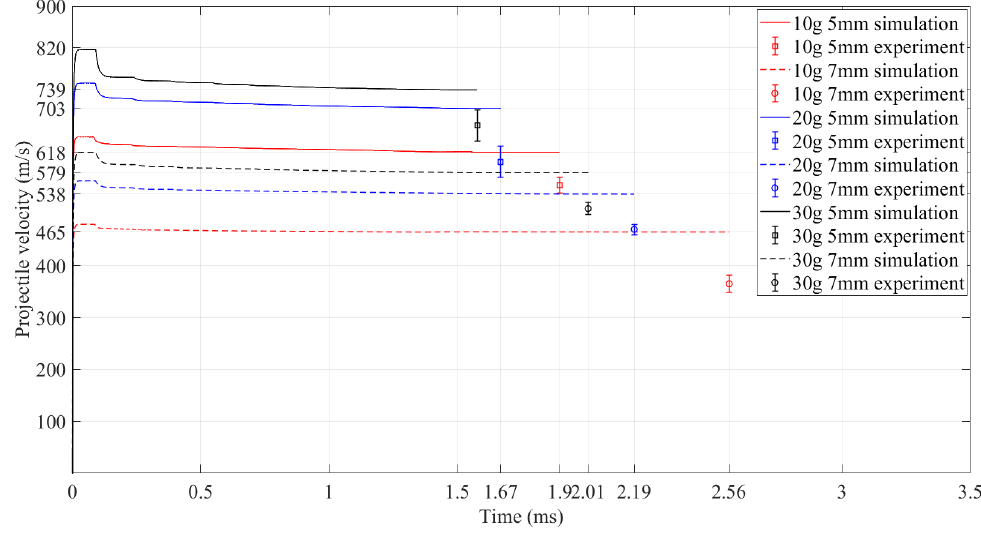
Figure 19. Comparison between experimental and numerical simulation results of the projectiles velocities at the tube’s exit (1200 mm) for detonation of 10, 20, and 30 g spherical explosive charges and 5 and 7 mm projectile